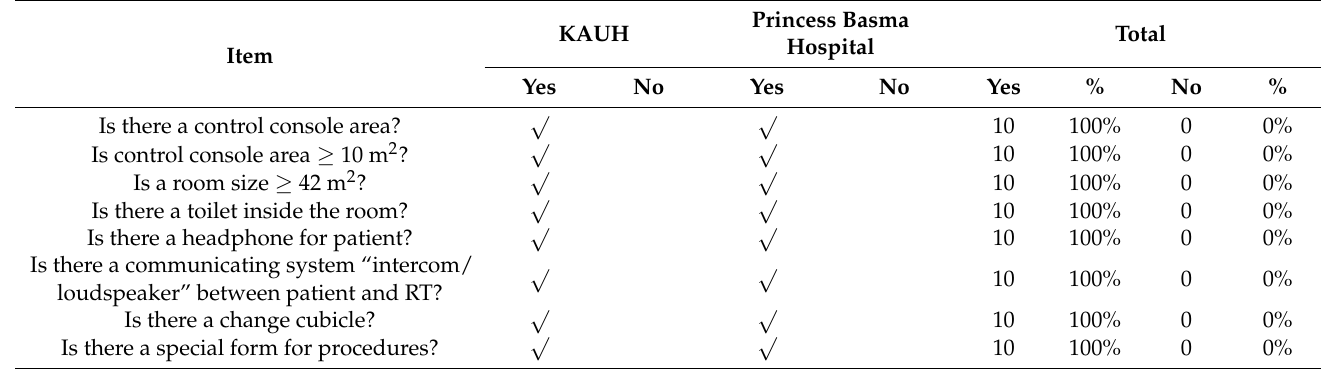
Table 8. Checklist for structure of MRI at public hospitals. (No. of samples =